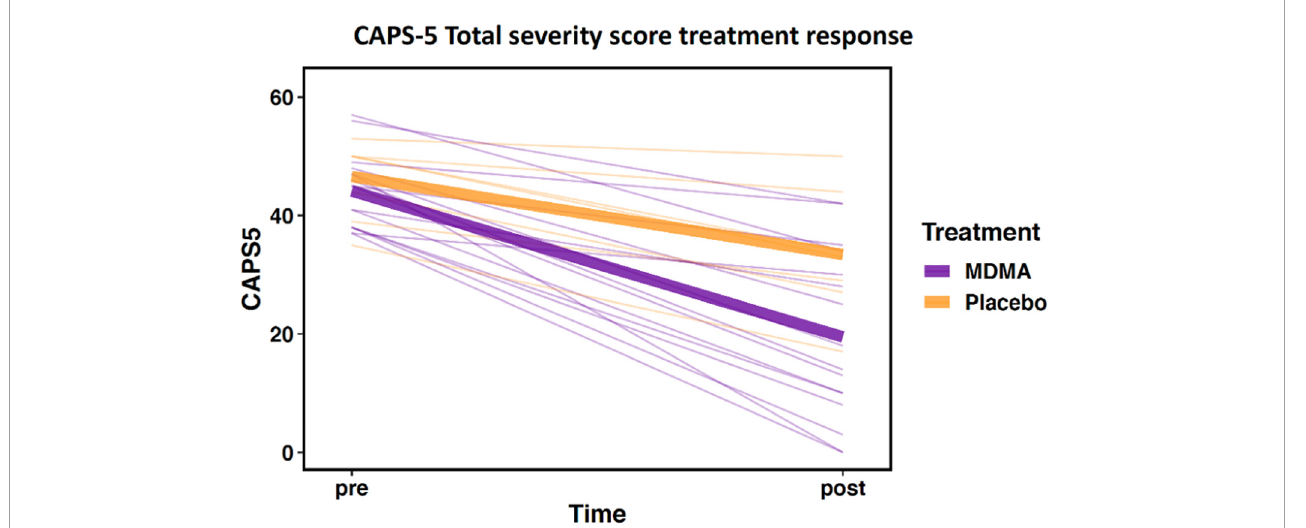
FIGURE1 Change in Clinician-Administered PTSD Scale for DSM-5 (CAPS-5) total severity score from pre- to post-treatment. Data demonstrate differential treatment response between 3,4-methylenedioxymethamphetamine (MDMA)-assisted therapy compared to therapy alone (data represent the subset of the clinical trial included in this study; MDMA, n = 16; placebo, n = 7). Thick lines represent group means, thin lines represent individual